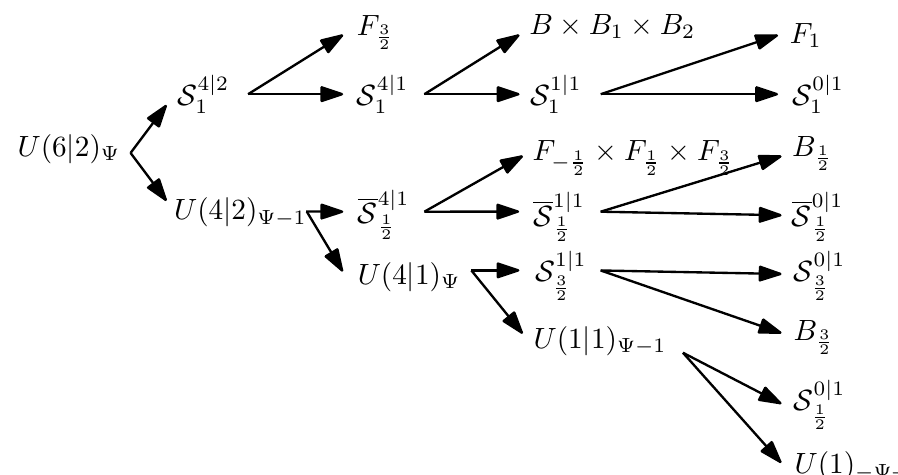
Figure 10. The structure of DS-reductions from the example